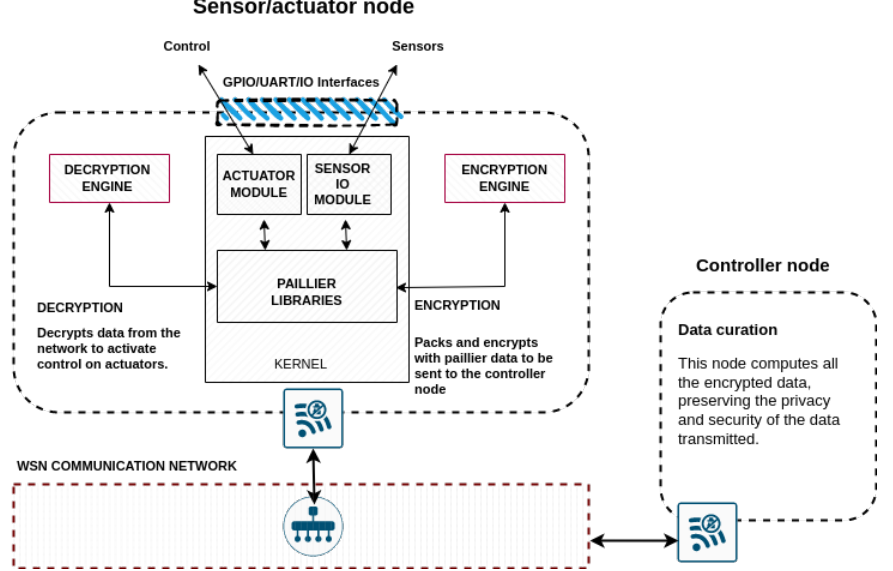
Figure 3. Computing infrastructure.